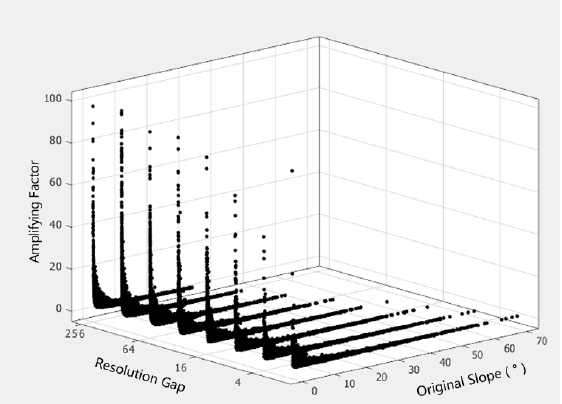
Figure 5. Relationship analysis among amplifying factor, resolution gap and